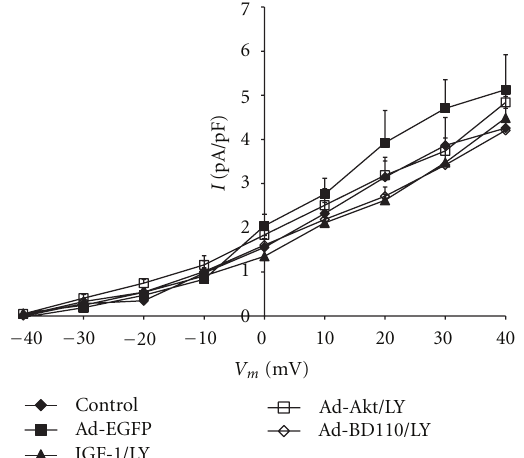
Figure 5: E ff ects of IGF-1 and Ad.Akt treatments on the I K1 - voltage relationship for normal neonatal rat cardiomyocytes. Data are presented as average current density (pA/pF) ± standard error. ∗ # Signficant di ff erences at P < 0 . 05 for control and Ad.EGFP versus IGF-1 and Ad.Akt treatments.